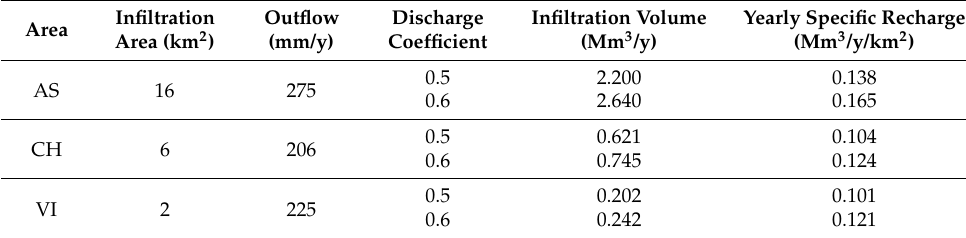
Table 7. Yearly specific recharge during monitoring